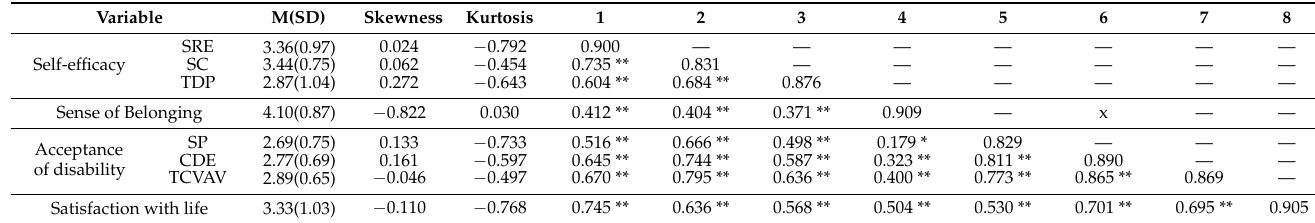
Table 2. Description statistics and correlations among the variables.